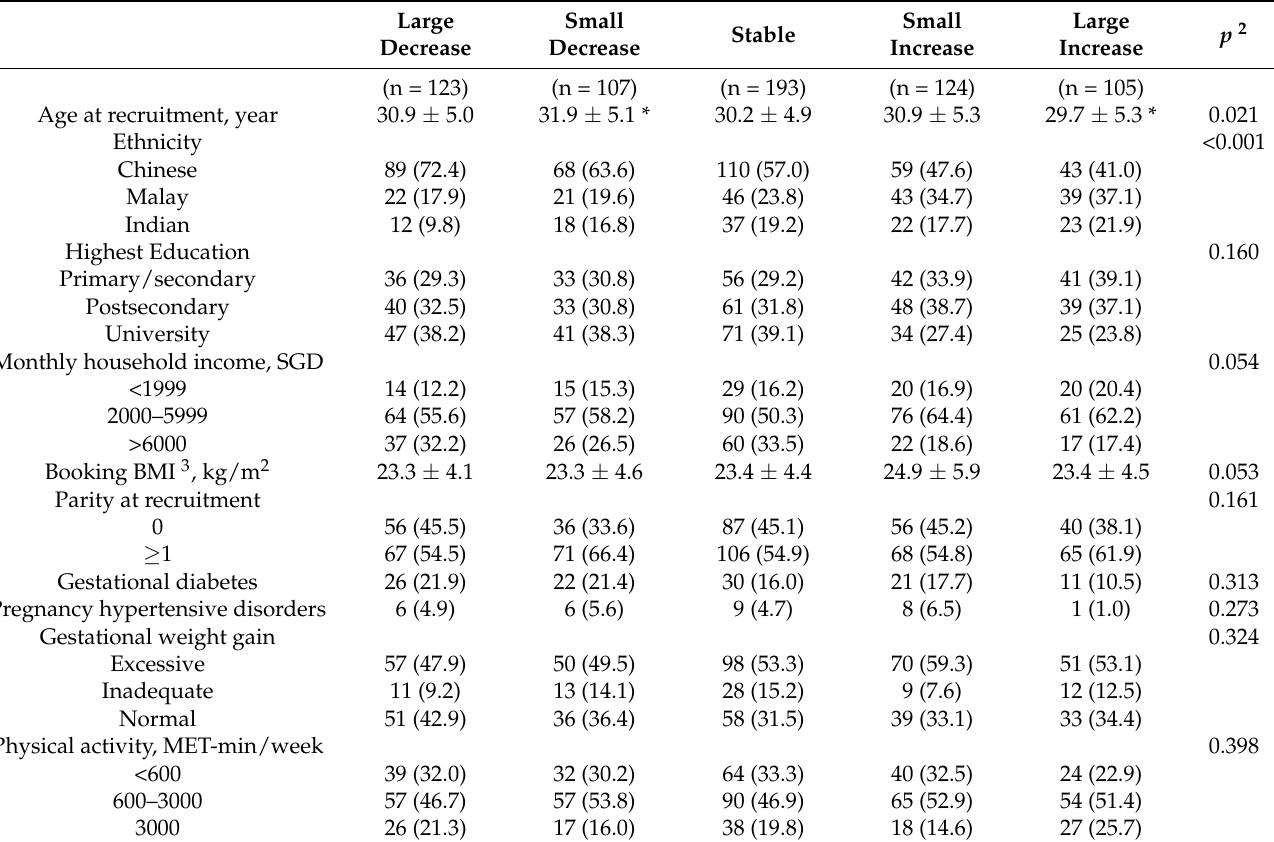
Table 1. Characteristics 1 of GUSTO women included in the analysis of change in diet quality with cardiometabolic risk markers (n =